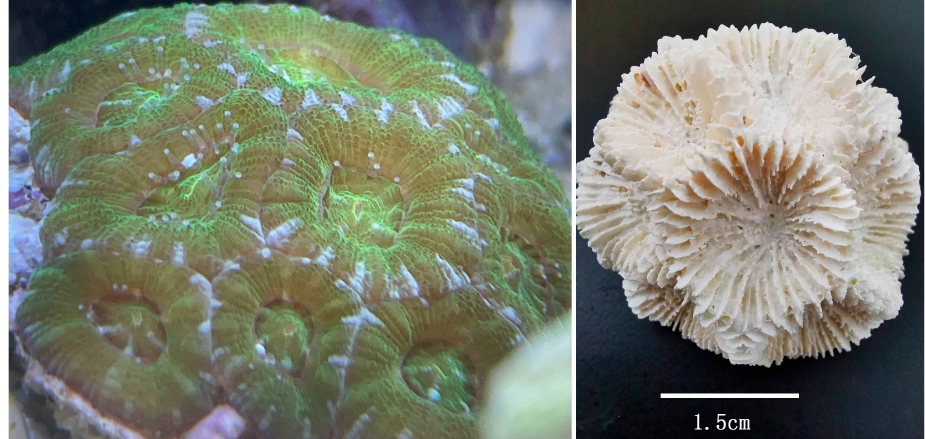
Figure 1. In situ live and skeleton photographs of Homophyllia bowerbanki .